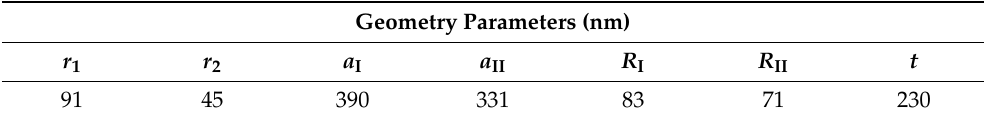
Figure 1. ( a , b ) Schematic diagrams of the one-dimensional hetero-optomechanical crystal nanobeam resonator; ( c ) the optomechanical crystal unit cell; ( d ) view of the defect area. Table 1. Geometric parameters of the optomechanical